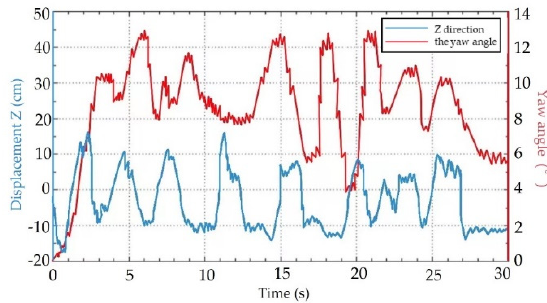
Figure 19. Displacement and yaw angle in the Z direction.